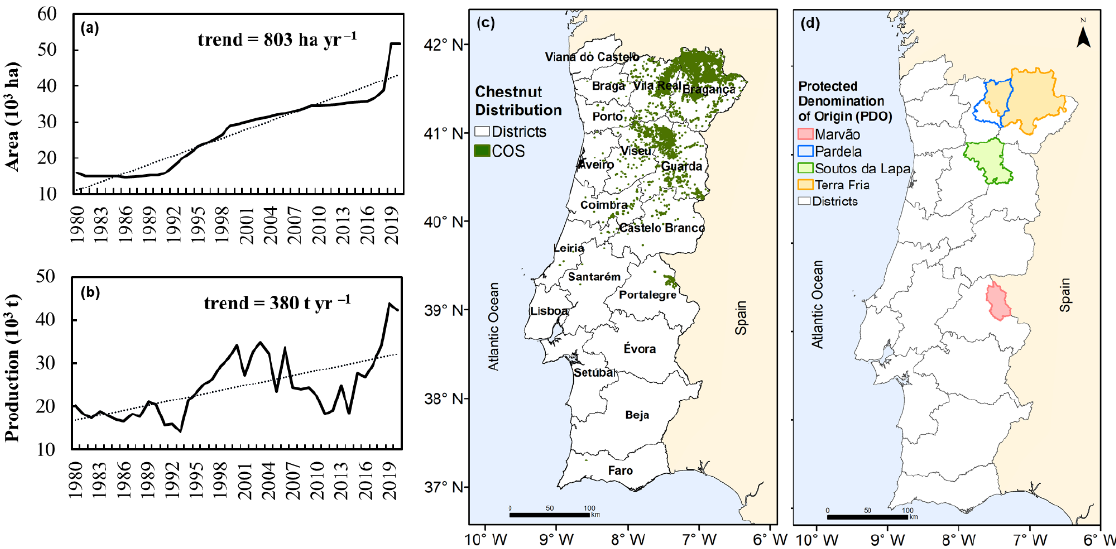
Figure 1. Chestnut ( a ) land cover area (hectares) and ( b ) yield (t) in Portugal, between 1980 and 2020. The linear regression trends are also shown, along with the corresponding trend value ( c ) chestnut distribution areas in mainland Portugal; ( d ) location of the chestnut Protected Denomination of Origin (PDO) regions [3,8].